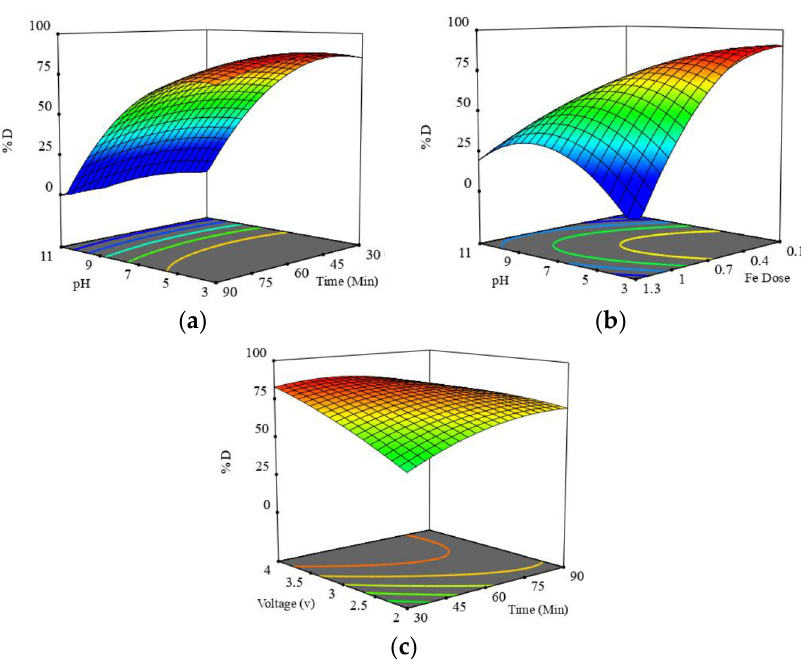
Figure 3. ( a – c ) The effect of PEF independent operational parameters (pH, time, Fe dose, and voltage) over the overall catalytic activity of electrodes in terms of %D (95% CI).